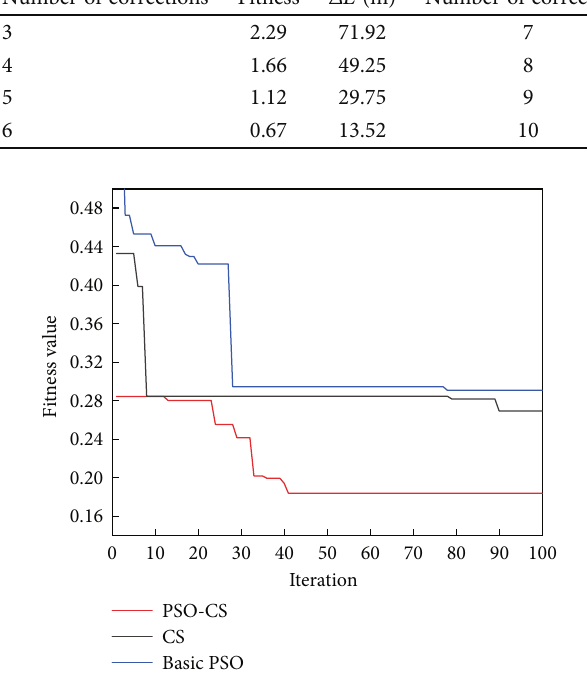
Figure 9: Comparison of the calculation results between PSO, CS, and PSO-CS algorithms. Table 2: The optimal results calculated by three di ff erent algorithms.